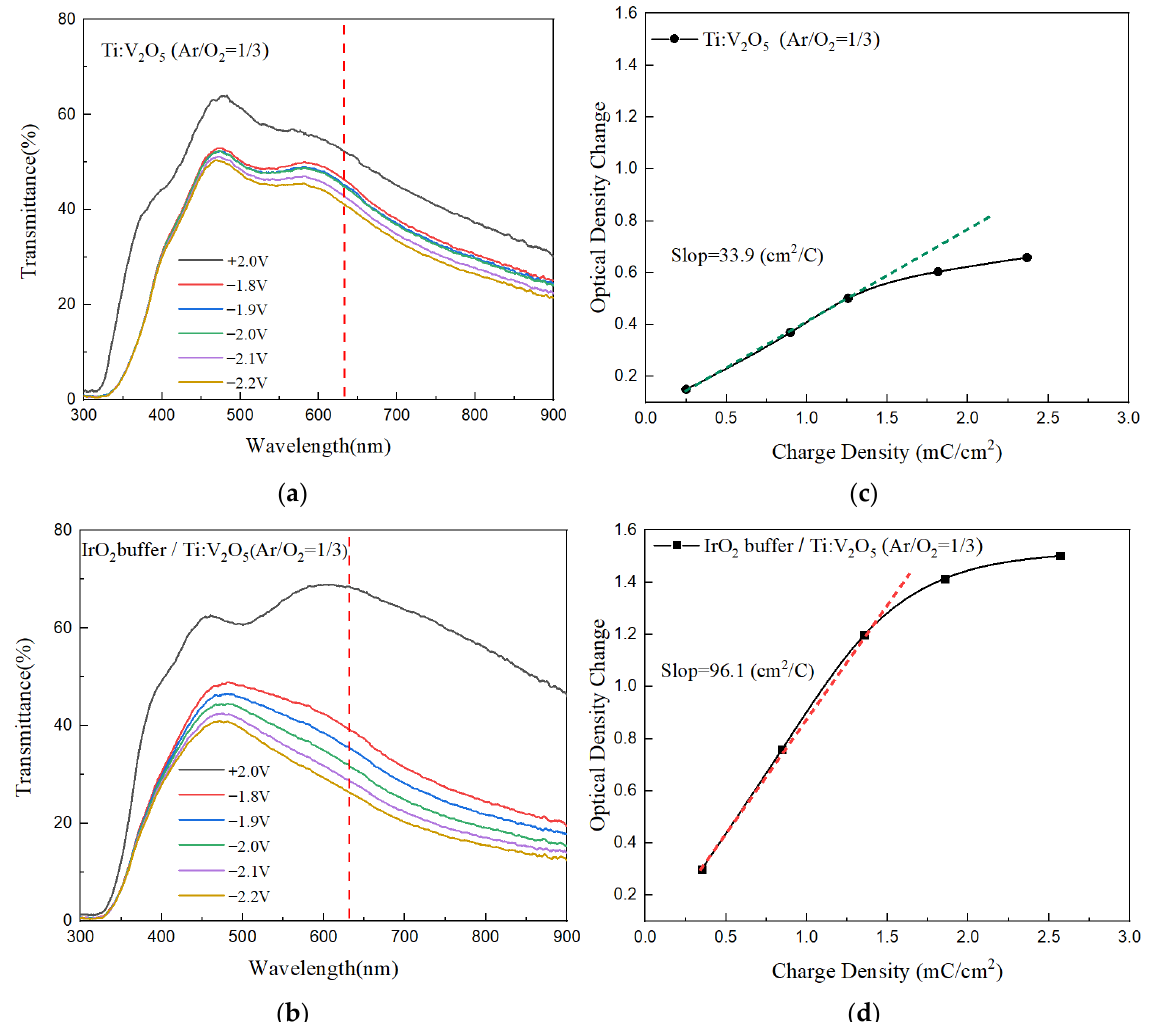
Figure 7. ( a , b ) Optical transmittance spectra of Ti:V 2 O 5 films and IrO 2 buffer/Ti:V 2 O 5 films at different applied potential voltages; ( c , d ) optical density change vs. charge density of Ti:V 2 O 5 films and IrO 2 buffer/Ti:V 2 O 5 films.